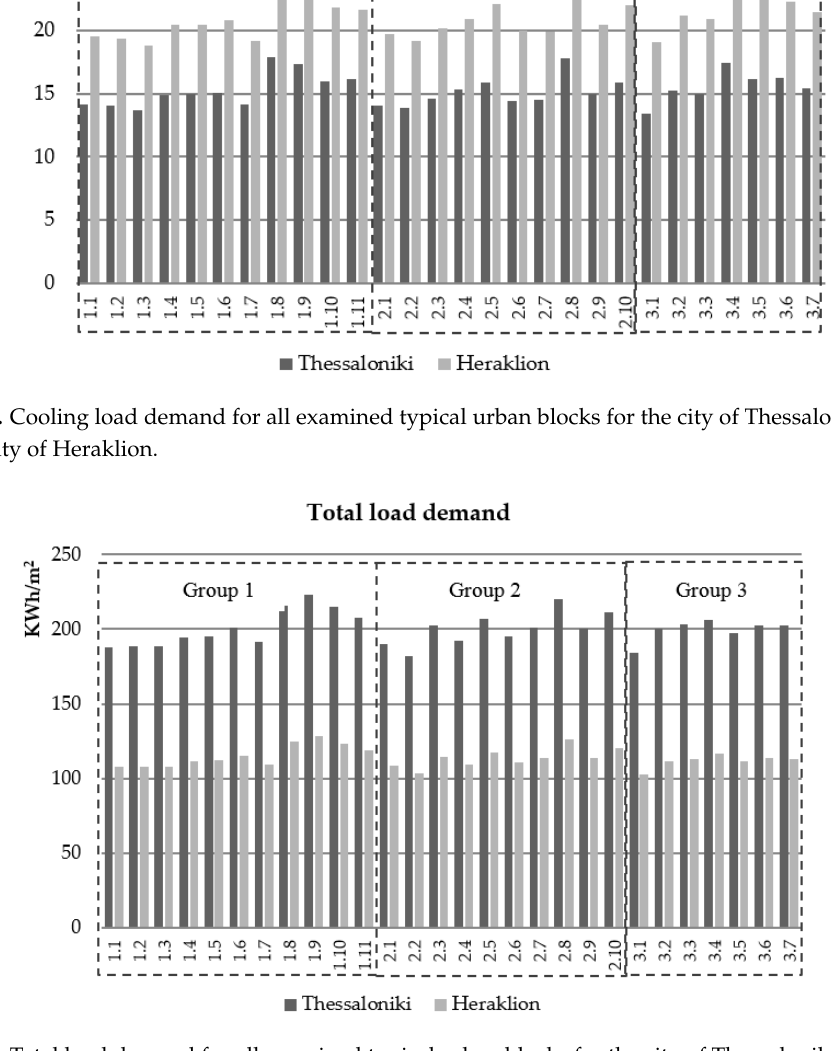
Figure 8. Total load demand for all examined typical urban blocks for the city of Thessaloniki and for the city of Heraklion.